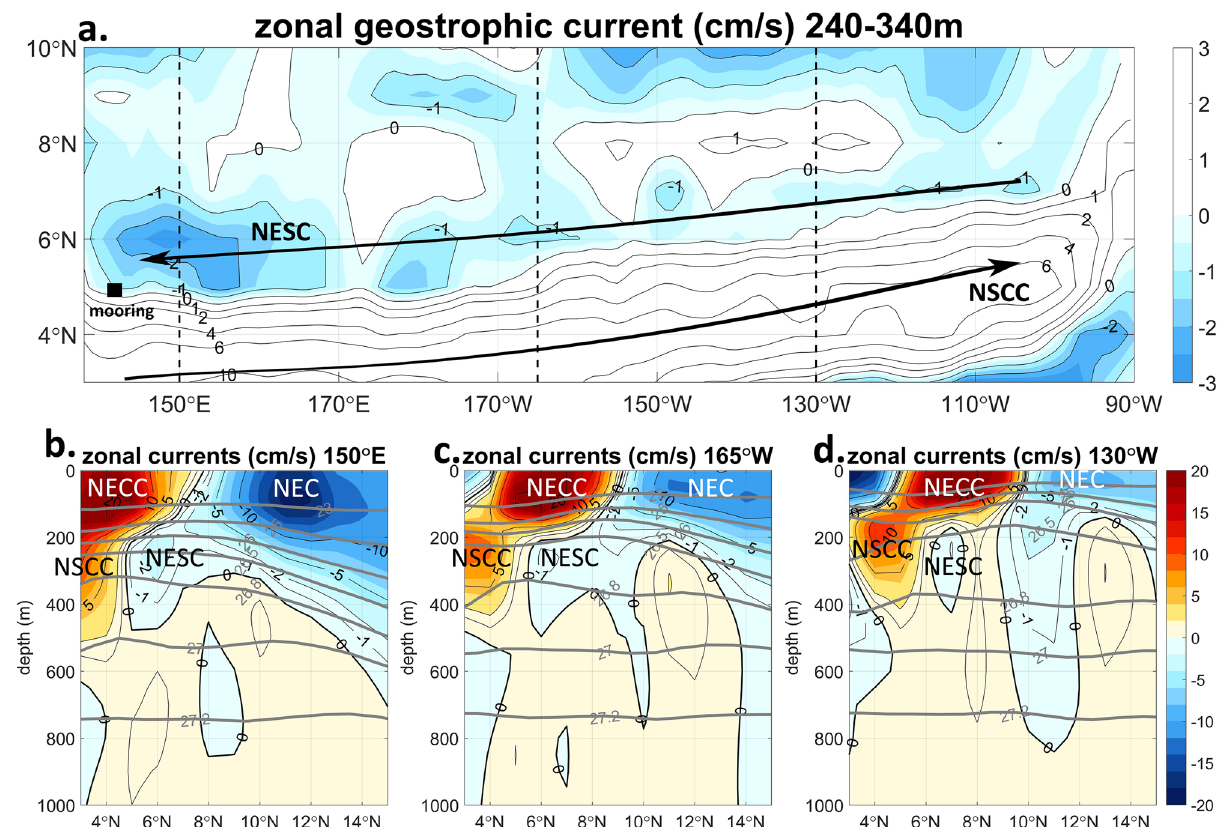
Figure 1. ( a ) Mean zonal Argo geostrophic currents vertically averaged between 240 and 340 m in the tropical North Pacific Ocean. The schematic axes of the major subsurface zonal currents, the Northern Subsurface Countercurrent (NSCC, a.k.a. Tsuchiya Jet) and the North Equatorial Subsurface Current (NESC) are marked. The mooring location and the meridonal sections of Argo profiles used in this paper ( b – d and Fig. 4) are also marked by a solid square and dashed lines, respectively. Mean zonal Argo geostrophic currents in the meridional sections of ( b ) 150° E, ( c ) 165° E, and ( d ) 130° W in the western, central and eastern Pacific Ocean, respectively. The major zonal surface (North Equatorial Current, NEC; North Equatorial Countercurrent, NECC) and subsurface (NSCC; NESC) currents in the northern equatorial Pacific Ocean are marked in ( b – d ). The mean currents are averaged from the monthly Argo geostrophic currents from 2014 to 2018. The currents are averaged within longitudinal range of 5° close to the sections. The grey contours mark the potential density surfaces (minus 1,000 kg m −3 ). Unit of the density is kg m −3 . The positive/negative values stand for eastward/ westward currents. Only the westward currents are shaded in color to highlight the location of the NESC in ( a ). Unit of currents is cm s −1 . The figure is generented by MATLAB software version R2019b (https ://www.mathw